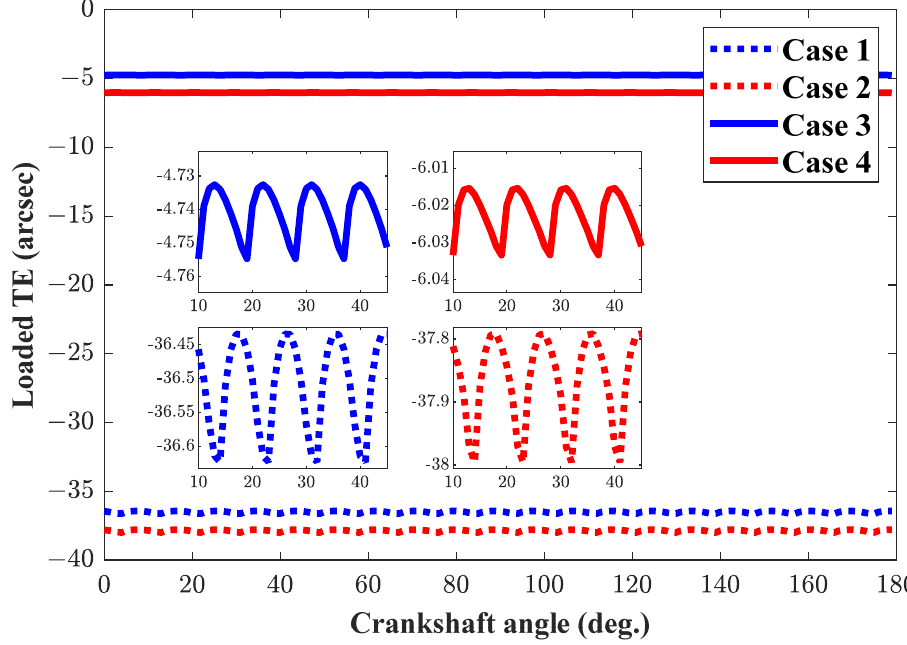
Figure 10. Comparison of the loaded transmission error within one mesh circle for four cases.